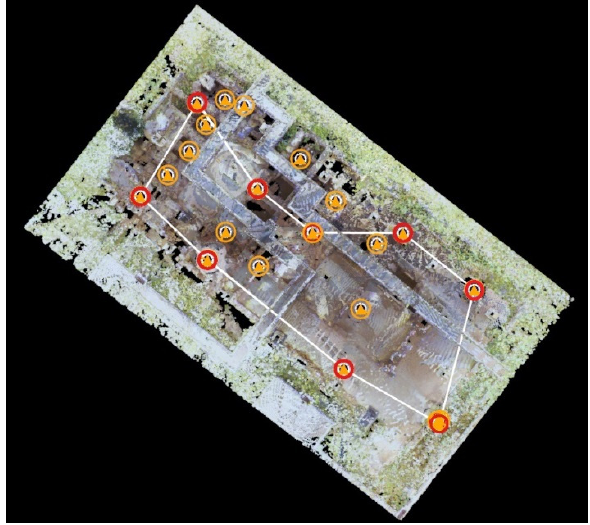
Figure 10. Cloud-to-Cloud registration between the 9 traverse and the 11 “single